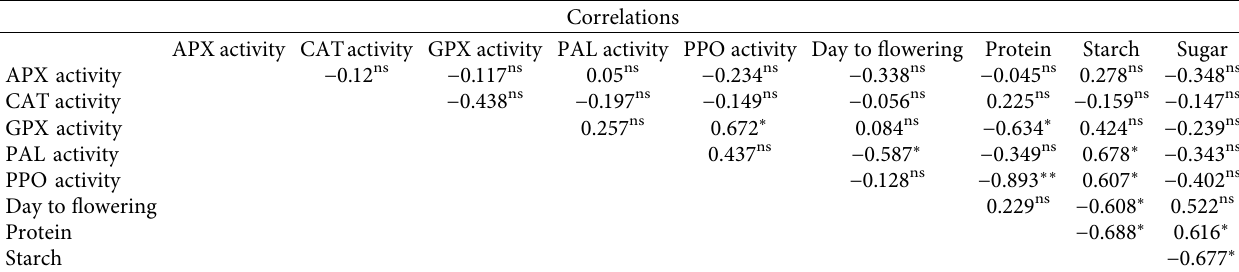
Table 2: Correlation between APX, CAT, GPX, PAL, PPO, day to flowering, stretch, and sugar content.